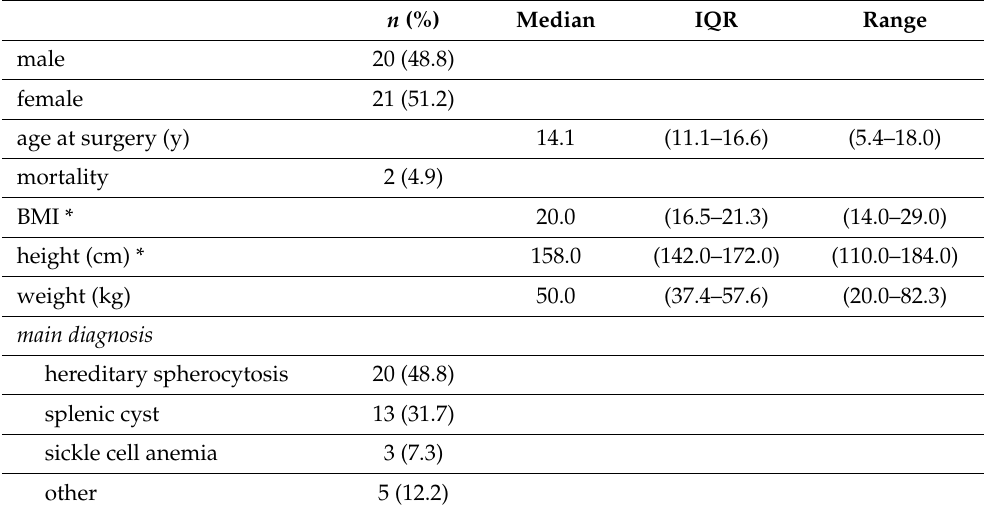
Table 1. Patient characteristics (total n =